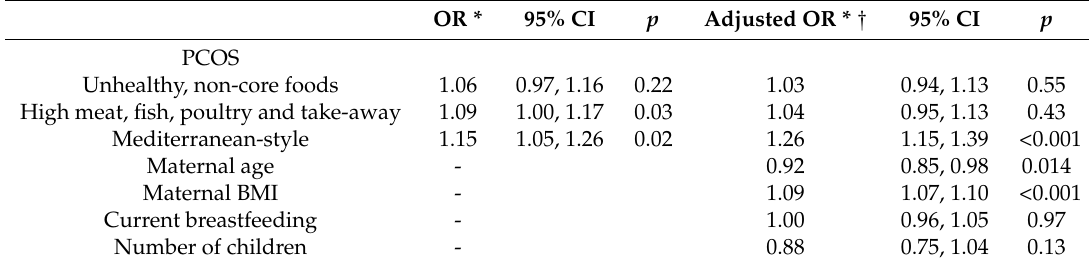
Table 3. Odds ratios for likelihood of PCOS according to the dietary patterns identified. OR * 95% CI